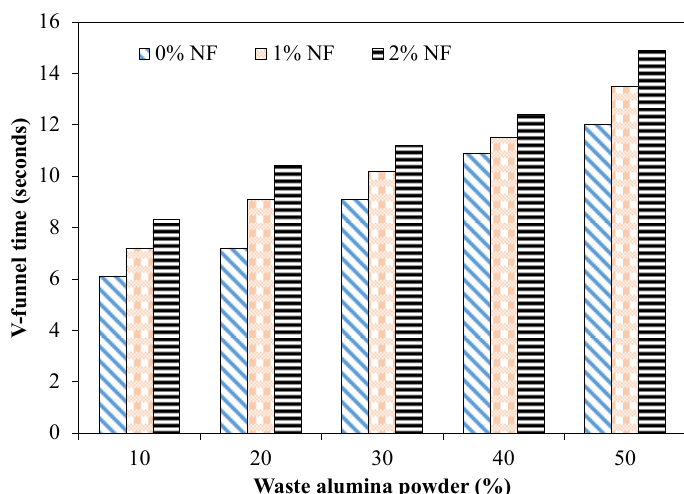
Figure 5. Flow time for mixture incorporating AP and NF.